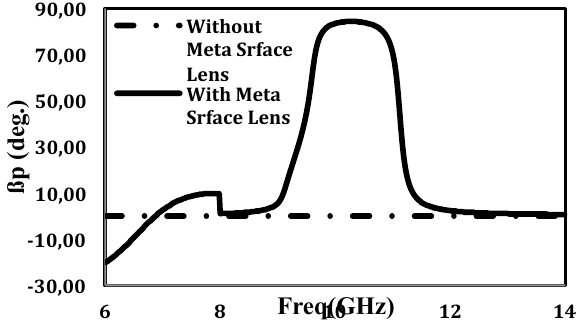
Figure 1(c): Phase variation of electromagnetic wave when passes through the unit cell with respect to